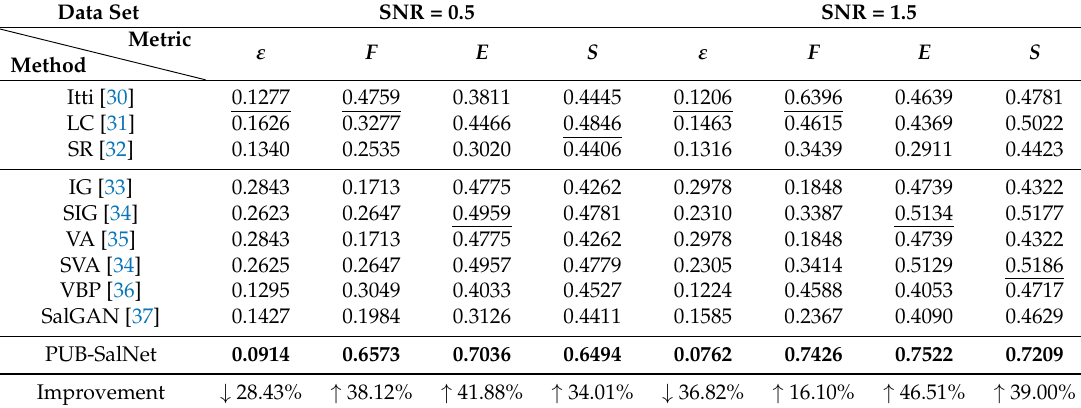
Table 1. Comparison of performance of ten unsupervised methods with four metrics on the simulated biomedical test sets. ε stands for Mean Absolute Error (MAE), F for region similarity, E for the enhanced alignment measure, and S for structural similarity. Lower is better for ε , and higher is better for the other three metrics. The results are calculated according to Equations (6)–(8). The best performance of each metric is in bold and the second best is underlined. The improvements of our PUB-SalNet over the best of other methods in relative percentage is shown in the last row.